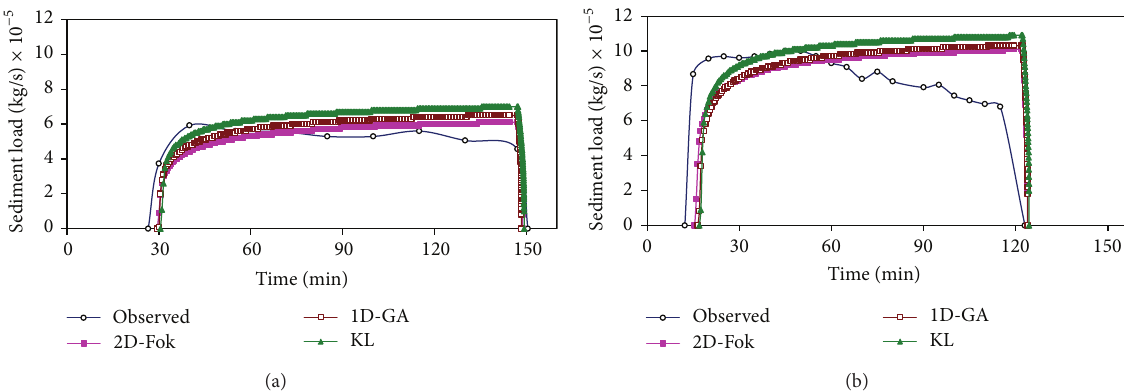
Figure 2: Comparison of observed and simulated sediment load (using YE) for (a) 6th February 2004 and (b) 17th February 2004 irrigation